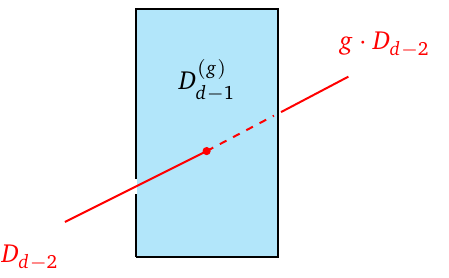
as in equation (30). d ´ 2